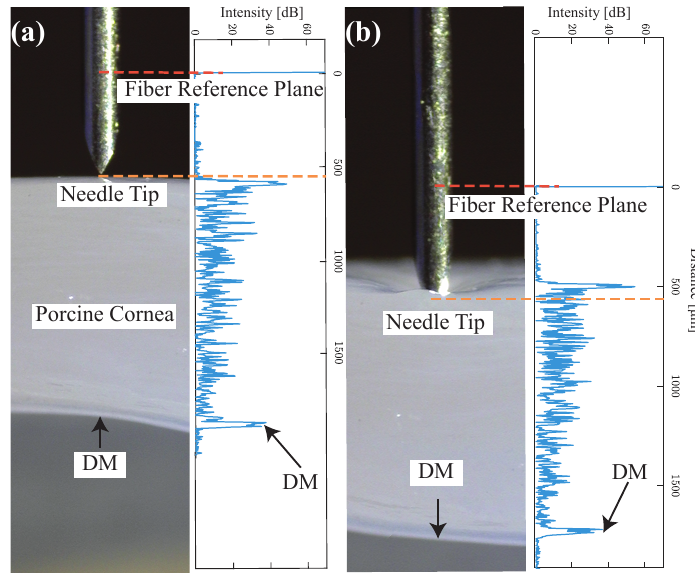
Figure 5. A-scan images (right side in ( a ) and ( b )) and corresponding microscope cross-sectional image (left side in ( a ) and ( b )) of cornea. The distance between the needle tip and the OCT sensor was pre-calibrated as 550 µ m, ( a ) when the needle is just above the cornea, ( b ) when the needle tip starts to pierce the cornea and causing maximum